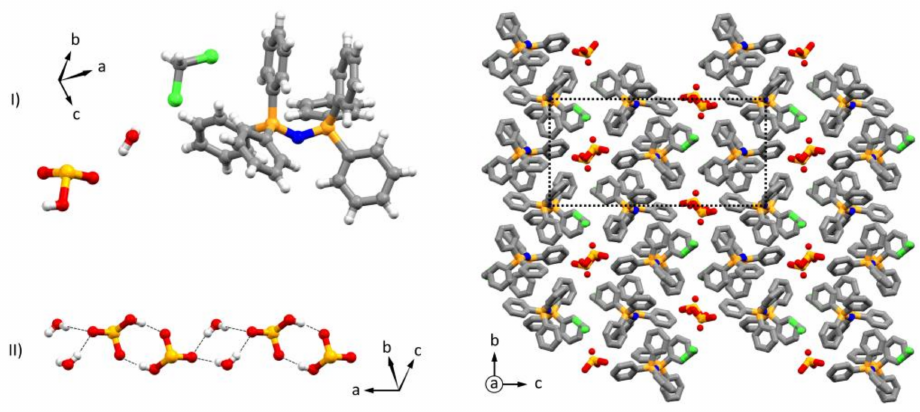
Figure 1. (I) Asymmetric unit of 1 , ball and stick representation; and (II) The chain formed by hydrogen selenite(IV) anions and water molecules is displayed in ball and stick representation. On the right, the crystal packing is shown along the crystallographic direction a ; and the hydrogen atoms are omitted for the sake of clarity. This is shown in a capped sticks